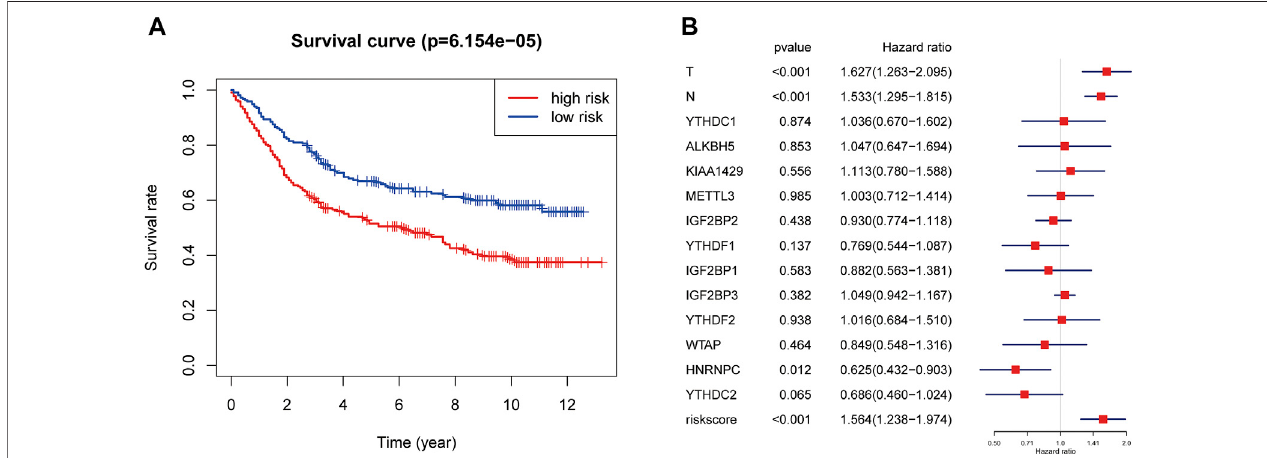
FIGURE 5 | Validation of the risk score prediction model using GEO database GSE84437. (A) Kaplan – Meier overall survival curves for patients in the GSE84437 database assigned to high- and low-risk groups based on the median risk score. (B) Multivariate Cox regression analyses of the association between clinical characteristics (including the risk score) and overall survival of GC patients in the GSE84437 database. GC, gastric cancer.